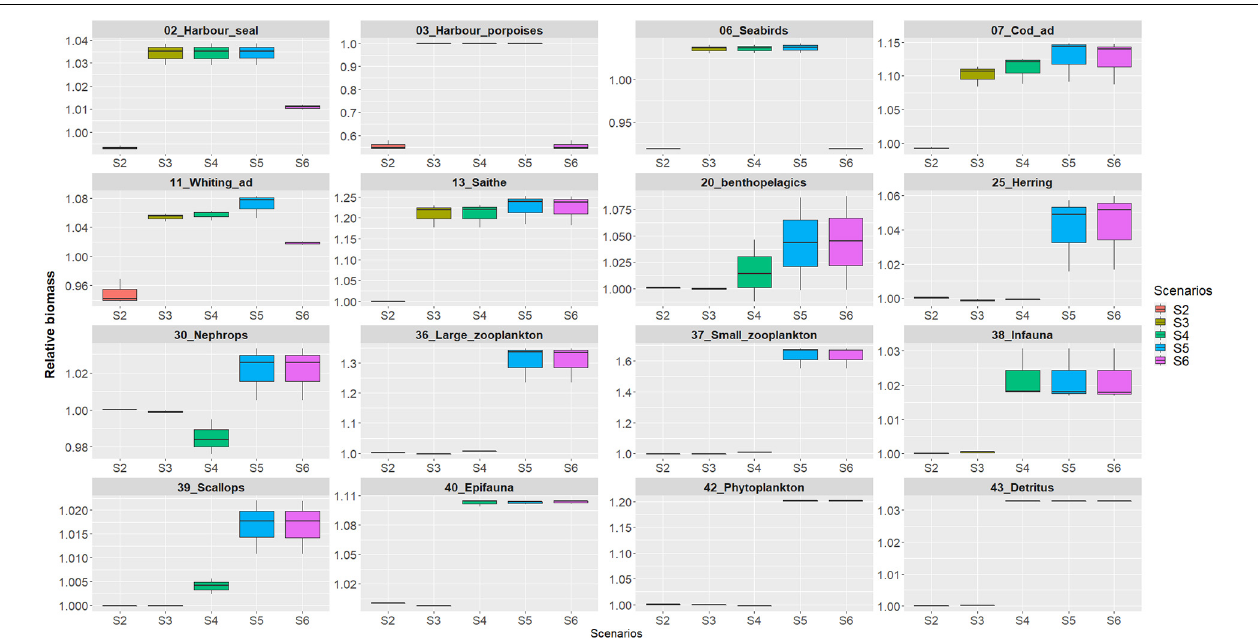
FIGURE 5 | Species relative annual biomasses changes (2011–2013) assessing the impact of MPP pressures within the region for each scenario. Biomass changes for scenarios 2–6 were visualized standardizing the species biomasses by the baseline “no addition of the